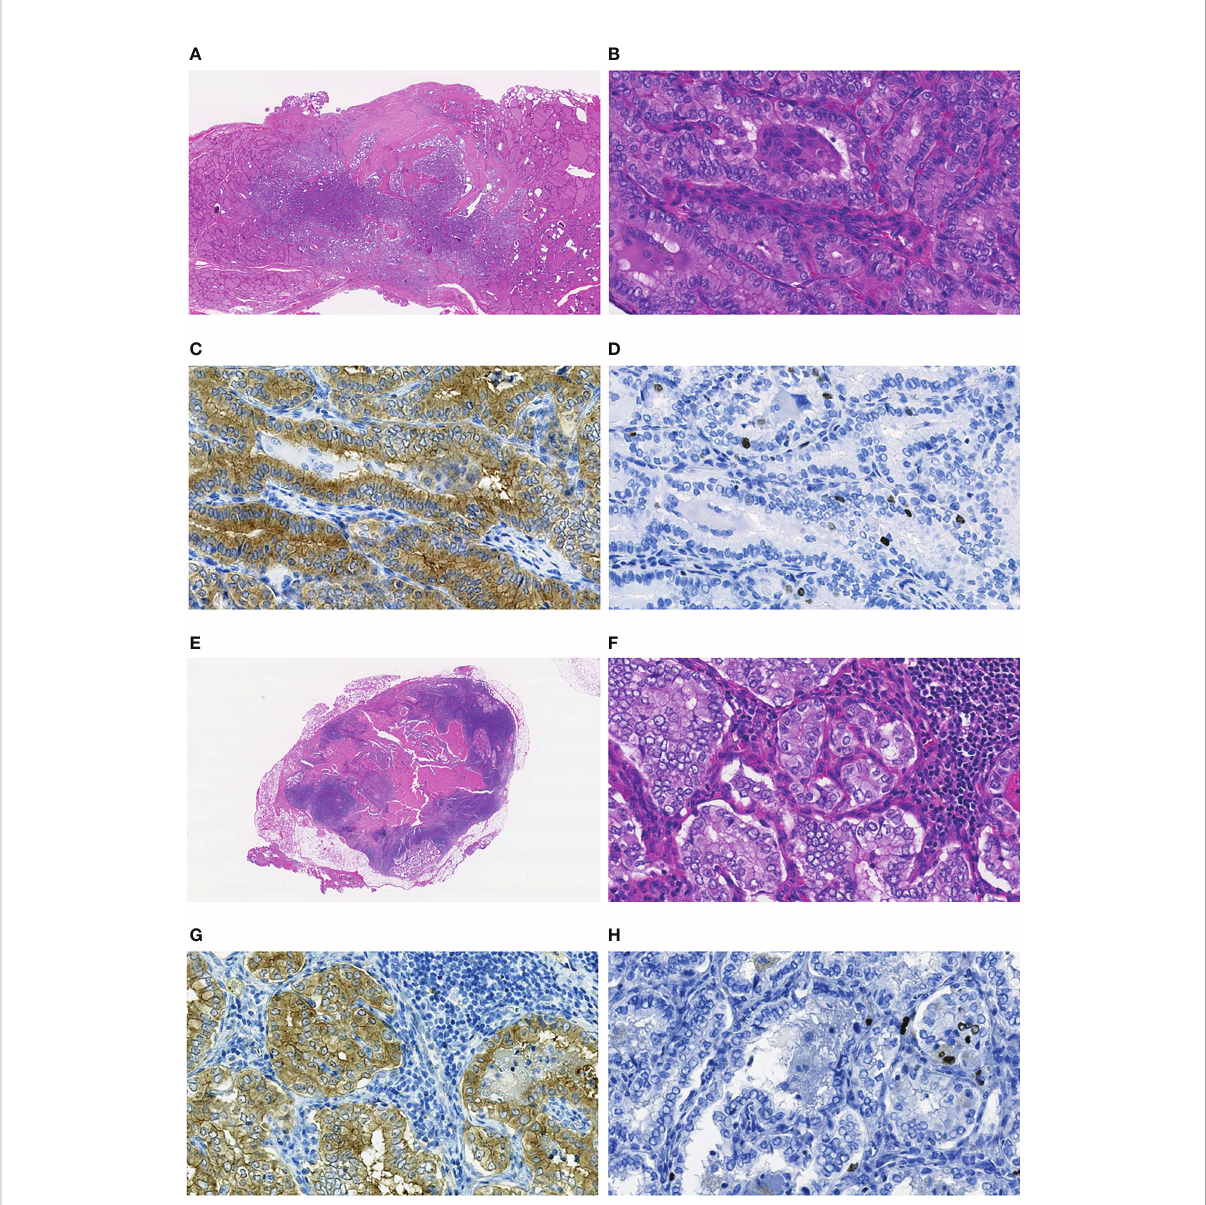
FIGURE 3 Sporadic recurrent MPTC sized 8 mm (pT1aN0M0 at the fi rst operation) removed from a 22-year-old male patient: (A – D) primary tumor, (E – H) the RAI-R recurrent metastasis. (A) Nonencapsulated primary tumor with follicular-papillary (conventional) growth pattern with extrathyroidal extension to the connective tissue, H&E, 15X magni fi cation. (B) Fragment of the primary tumor with papillary structures featuring tall cell areas and oncocytic changes, H&E, 400X magni fi cation. (C) Primary tumor: positive IHC reaction with the anti-BRAF (mutated V600E) antibody, 400X magni fi cation. (D) Primary tumor: IHC reaction with Ki67 (Clone MIB-1) antibody (Ki67 LI 3.1%), 400X magni fi cation. (E) RAI-R recurrent metastasis with cystic changes removed 1.3 years after the fi rst surgery, H&E, 15X magni fi cation. (F) Fragment of the RAI-R recurrent metastasis with solid structure and oncocytic changes, H&E, 400X magni fi cation. (G) fragment of the RAI-R recurrent metastasis: positive IHC reaction with anti-BRAF (mutated V600E) antibody, 400X magni fi cation. (H) RAI-R recurrent metastasis: IHC reaction with Ki67 (Clone MIB-1) antibody (Ki67 LI 3.3%), 400X magni fi